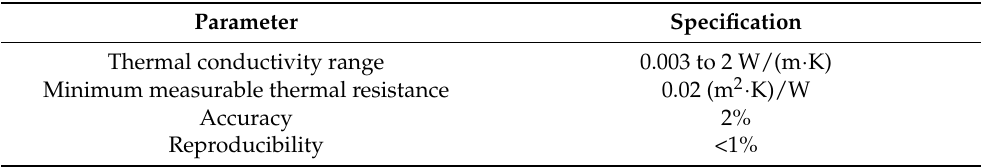
Table 3. Technical specification of GHP 456 Titan.